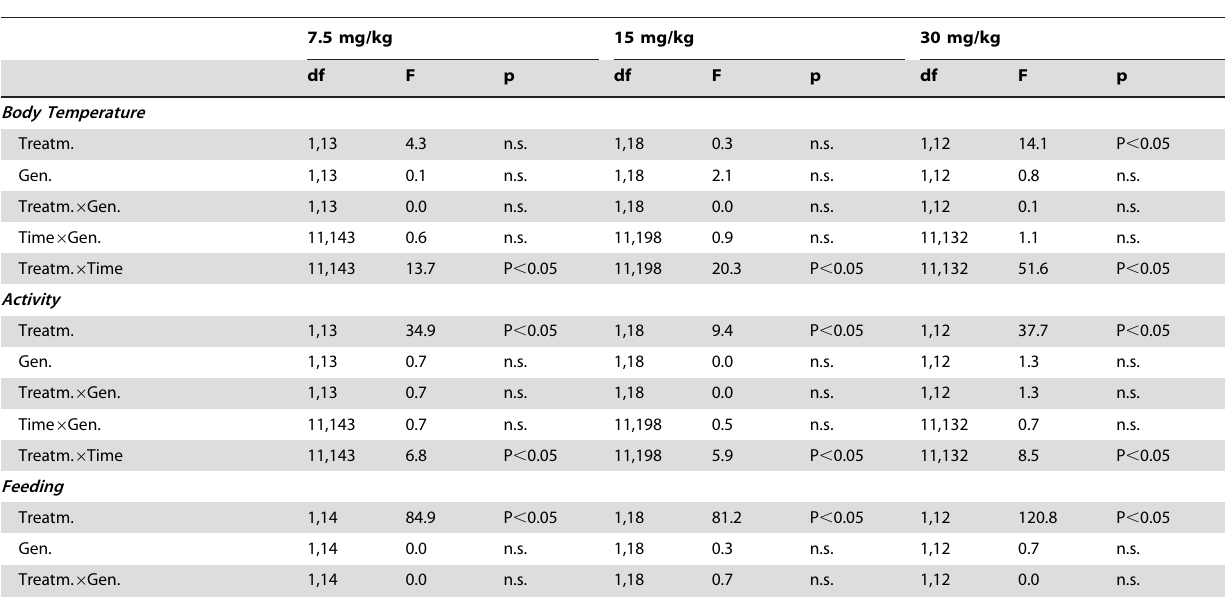
Table 2. The effects of C75 on body temperature, activity and feeding: statistical